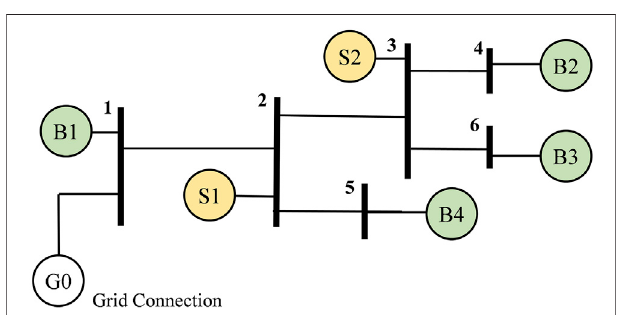
TABLE 3 | Generator parameters (in